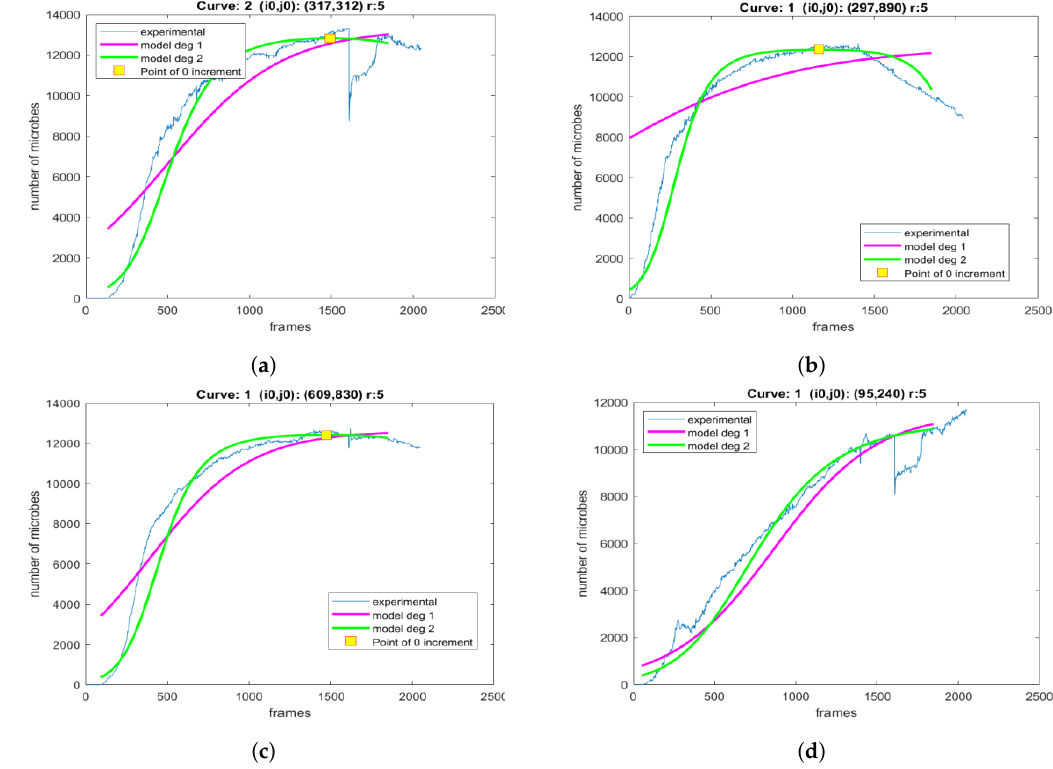
Figure 19. The modeling of the generated experimental curves with LF and LFSD for area of size r = 5, around the central point. The curves are extracted from locations marked as ( a ) A, ( b ) B, ( c ) C, and ( d ) D on the final frame of the petri dish